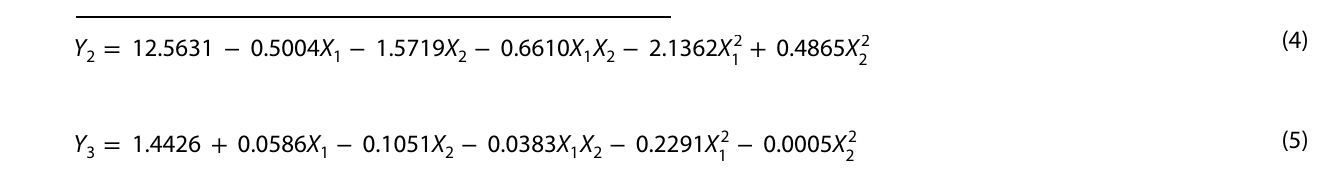
Table 2 Precision and accuracy